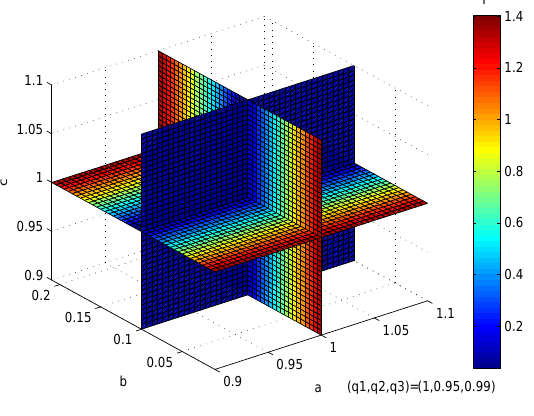
Figure 4. Distribution of the objective function values for system